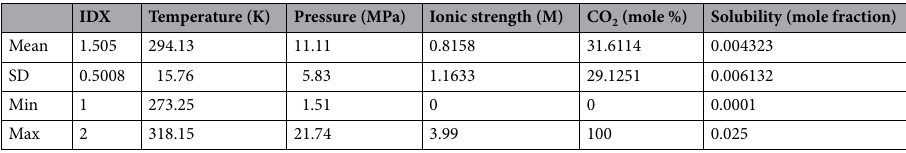
Table 1. Statistical details of the dataset in this